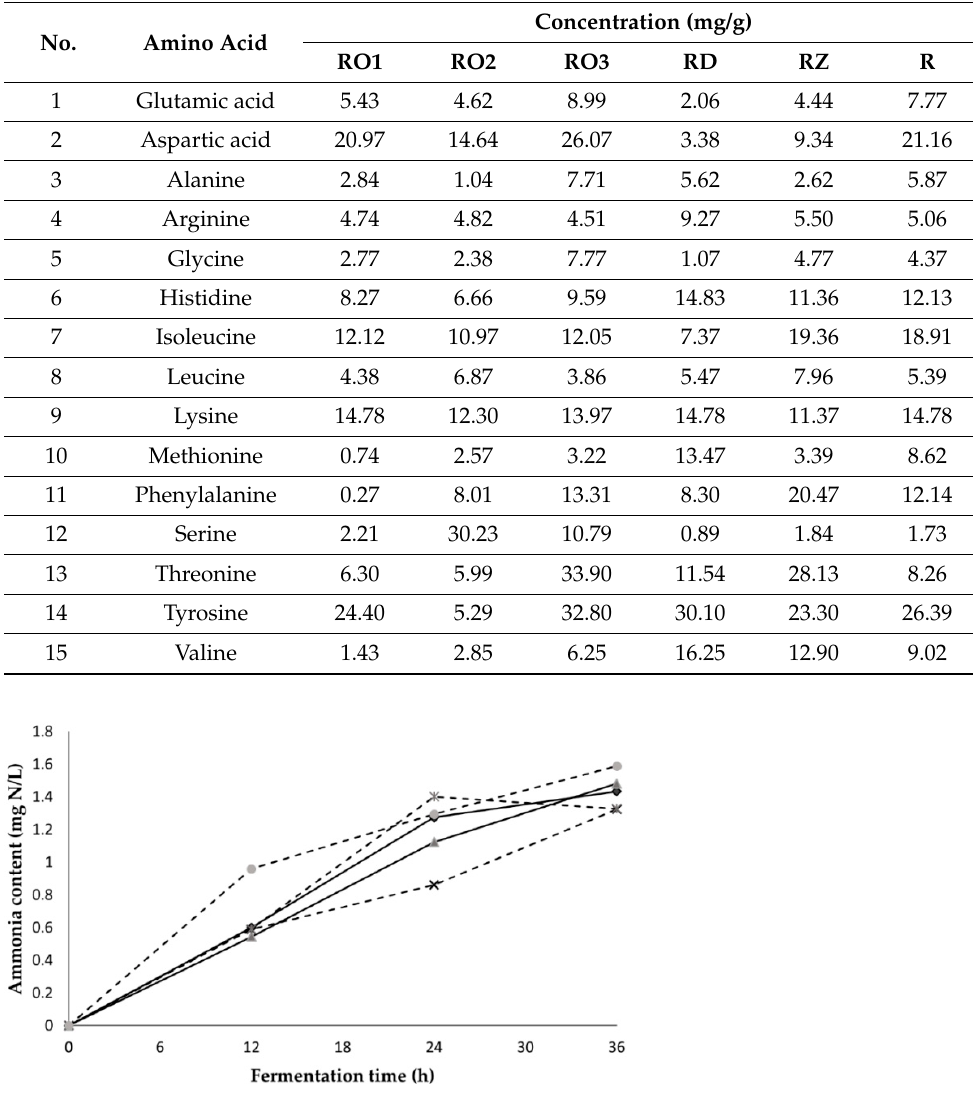
Table 2. Profile of amino acids of the fermented soybean with various Rhizopus strains. No.